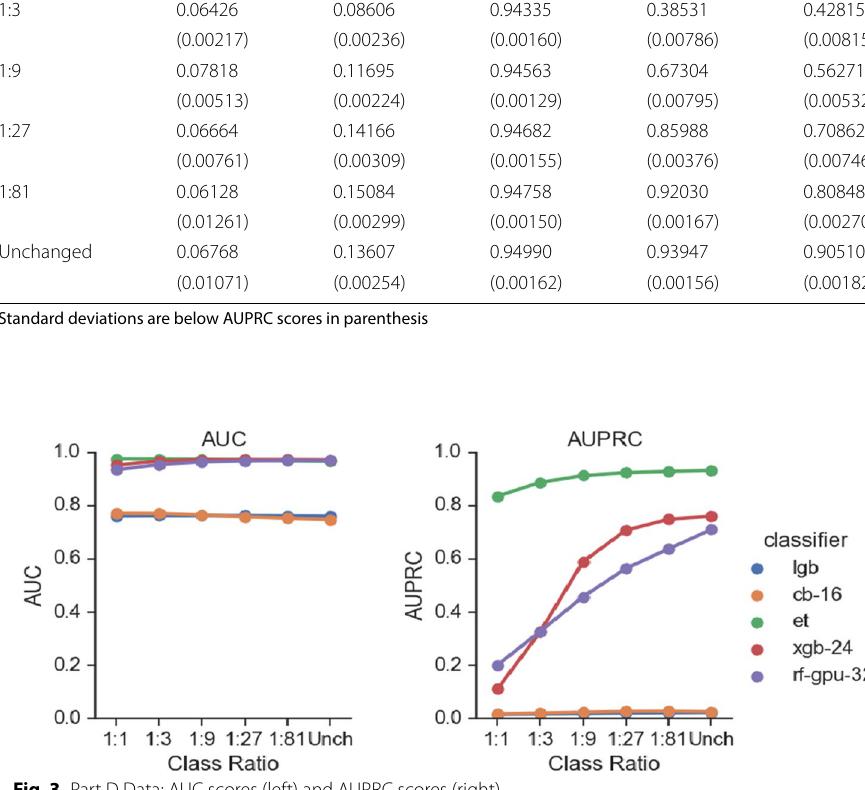
Fig. 3 Part D Data: AUC scores (left) and AUPRC scores (right)